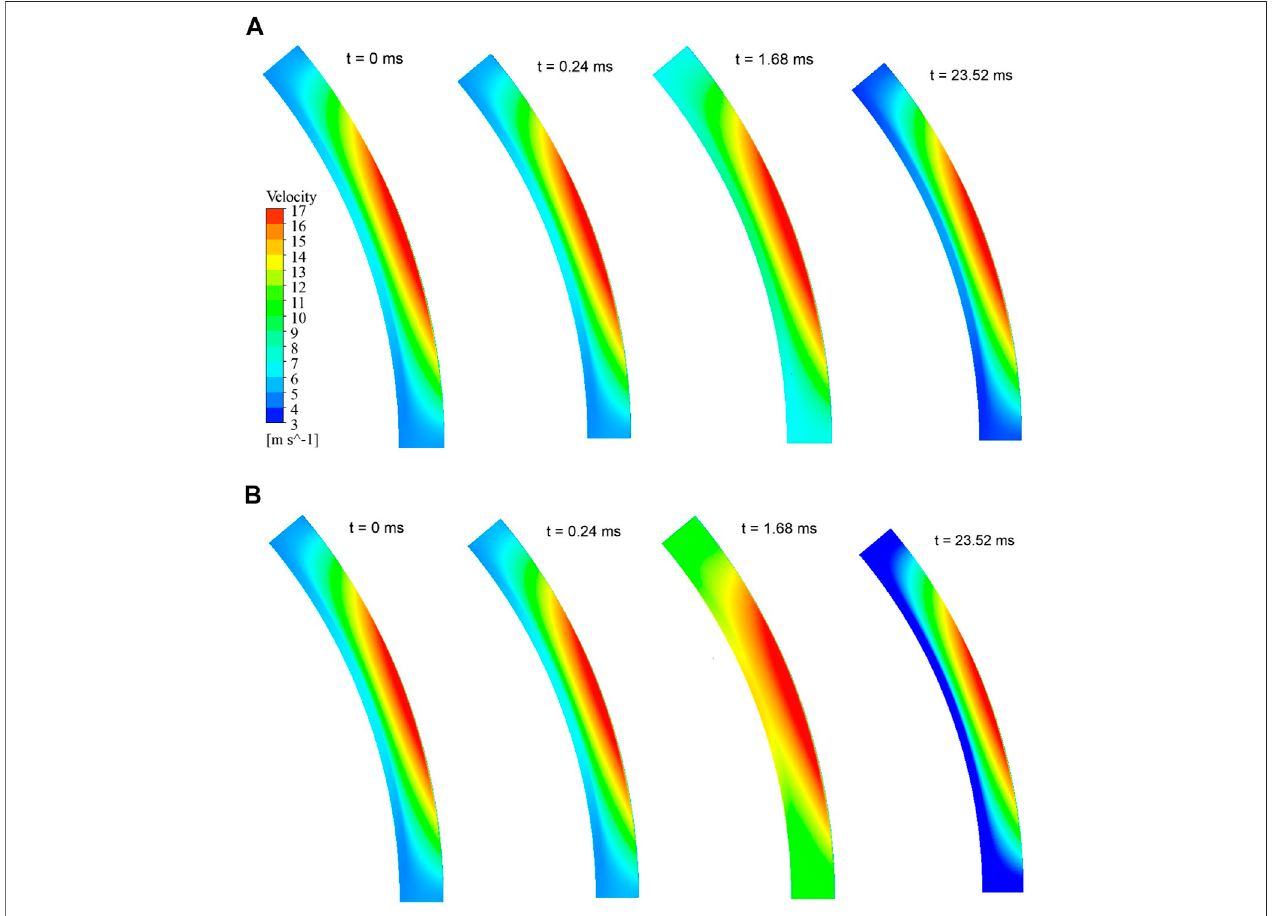
FIGURE 8 | Velocity distribution varies with time (A) a = 4% and (B) a = 10%.